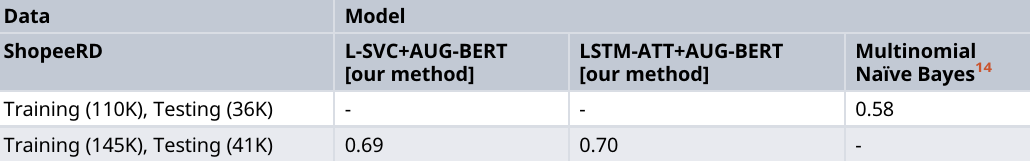
Table 3. Comparison of our models with others research work on